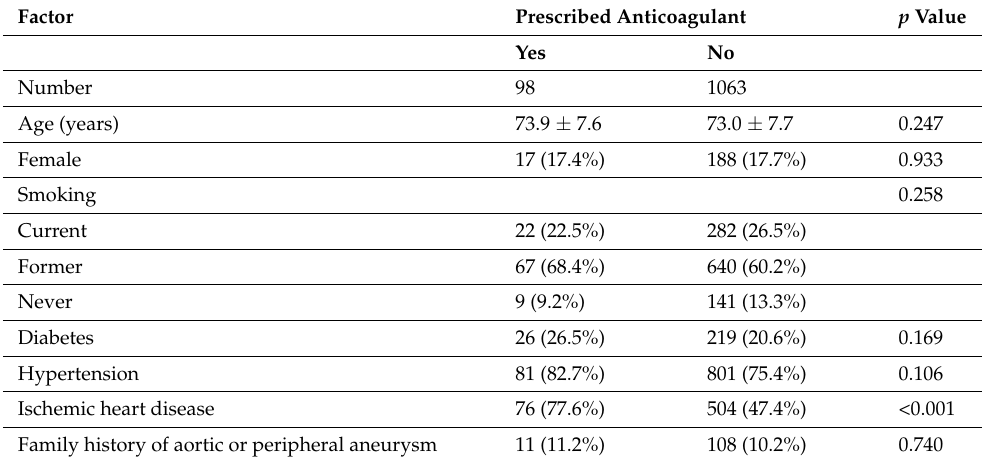
Table 1. Characteristics of patients in relation to prescription of an